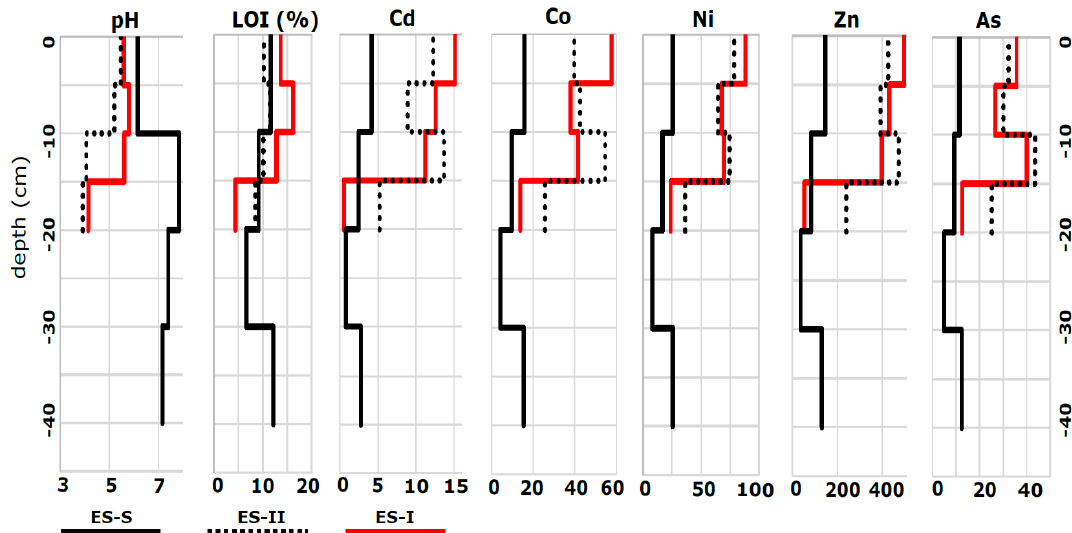
Figure 5. Vertical gradients (in cm below the sediment surface) of pH, organic matter (estimated as